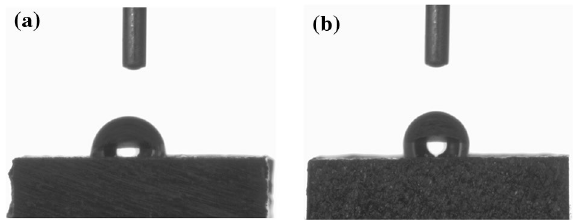
Figure 5. The representative images of droplets contacted on the coatings for 60 s ( a ) the MAO and ( b ) chitosan-based MAO surfaces.